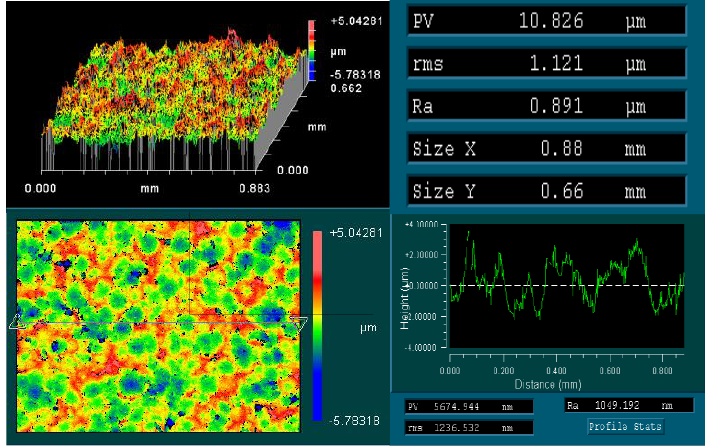
Figure 2. The surface roughness of pre-bonding samples after surface treatment.